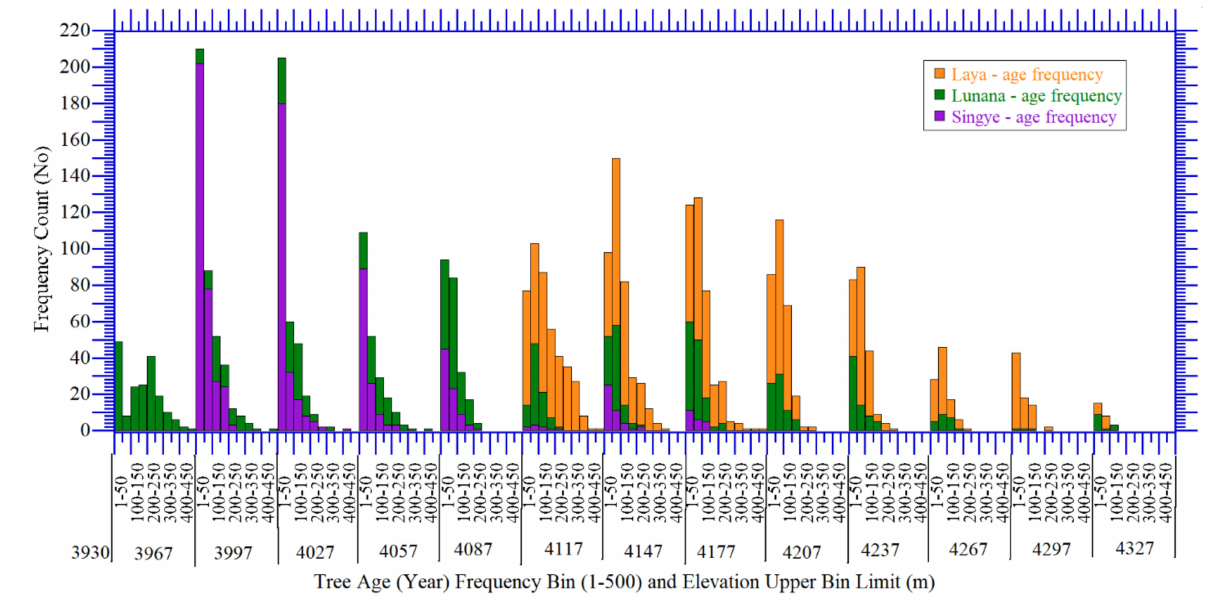
Figure 5. Frequency distribution against tree age classes and elevation classes in three treeline ecotones. Treeline ecotones of all ten transect bands in Lunana (green stake column), Laya (golden stake column) and Singye (purple stake column) portray their frequency distribution (Unimodal, reverse J-shaped) in their respective